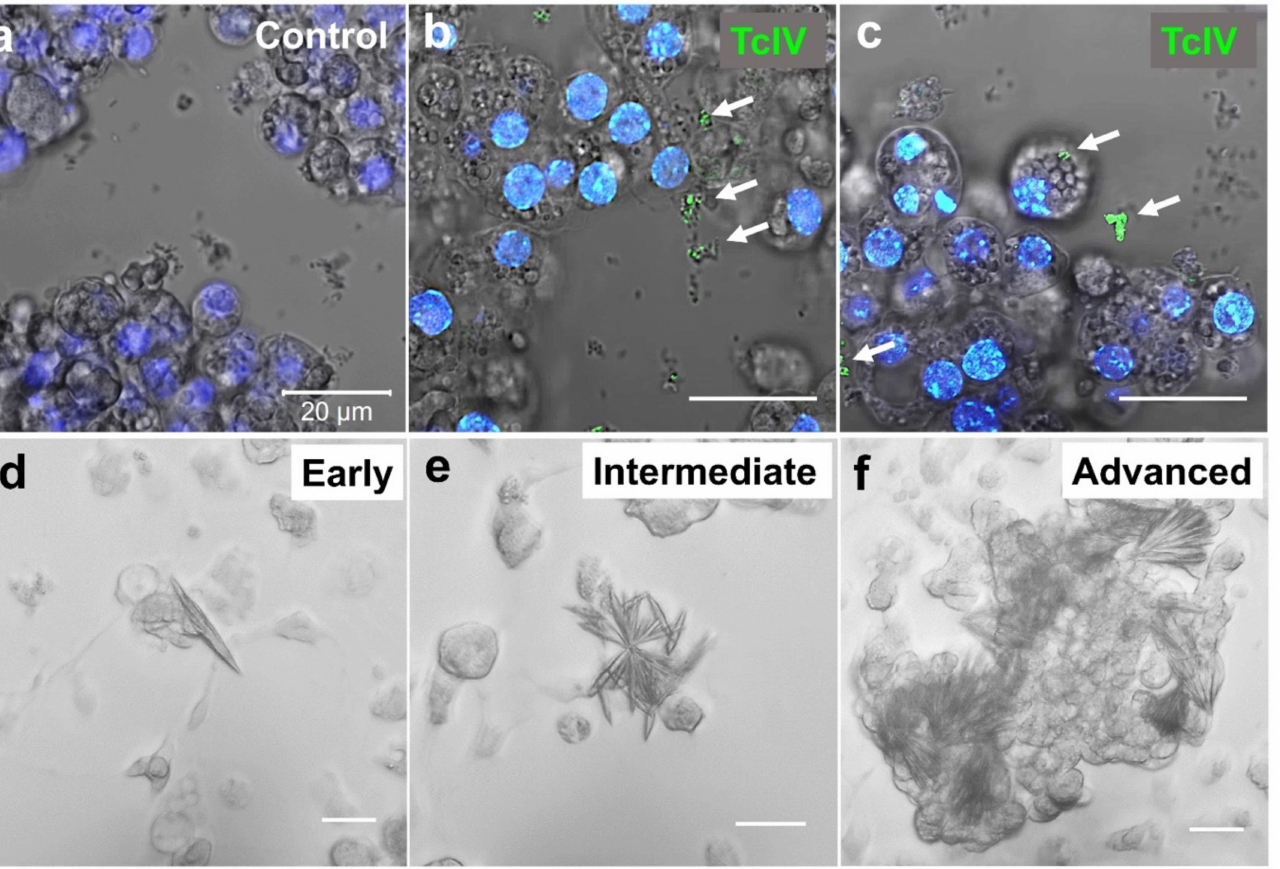
Figure 6. TcA cell line immunocytochemistry ( a – c ) and mineral crystal formations ( d – f ). TcA cell line was stained with an antibody raised in rabbit against TcIV -VP2. Rabbit IgG control did not show specific staining ( a ). The green dots pointed by white arrows show the virus particles stained with TcIV antibody in extracellular debris ( b ) and intracellular particles ( c ). The blue staining shows the nuclei stained with Hoechst (2.5 µ g/mL). ( d – f ) show the different degrees of mineral crystal formation in TcA cell line infected by TcIV . Image processing was done by ZEN Microscopy Software. The bars are all for 20 µ